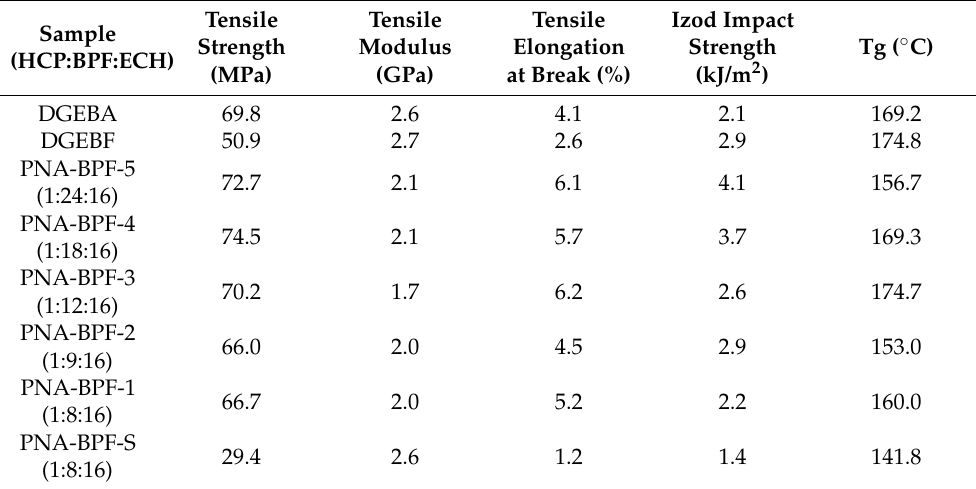
Table 7. Tensile and impact properties and glass transition temperature of the cured epoxy resins compared to base epoxy resins.